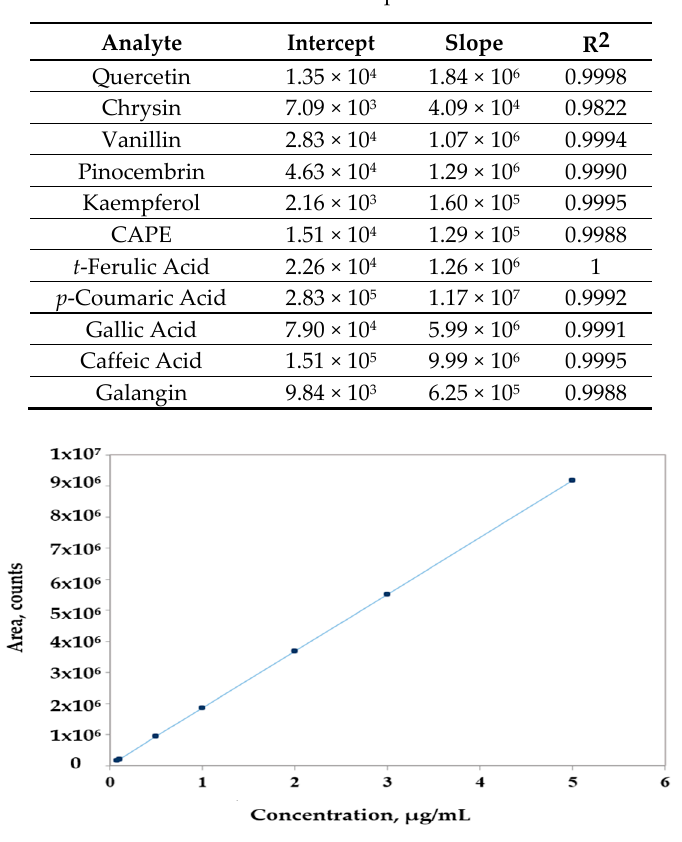
Table 3. Calibration parameters.